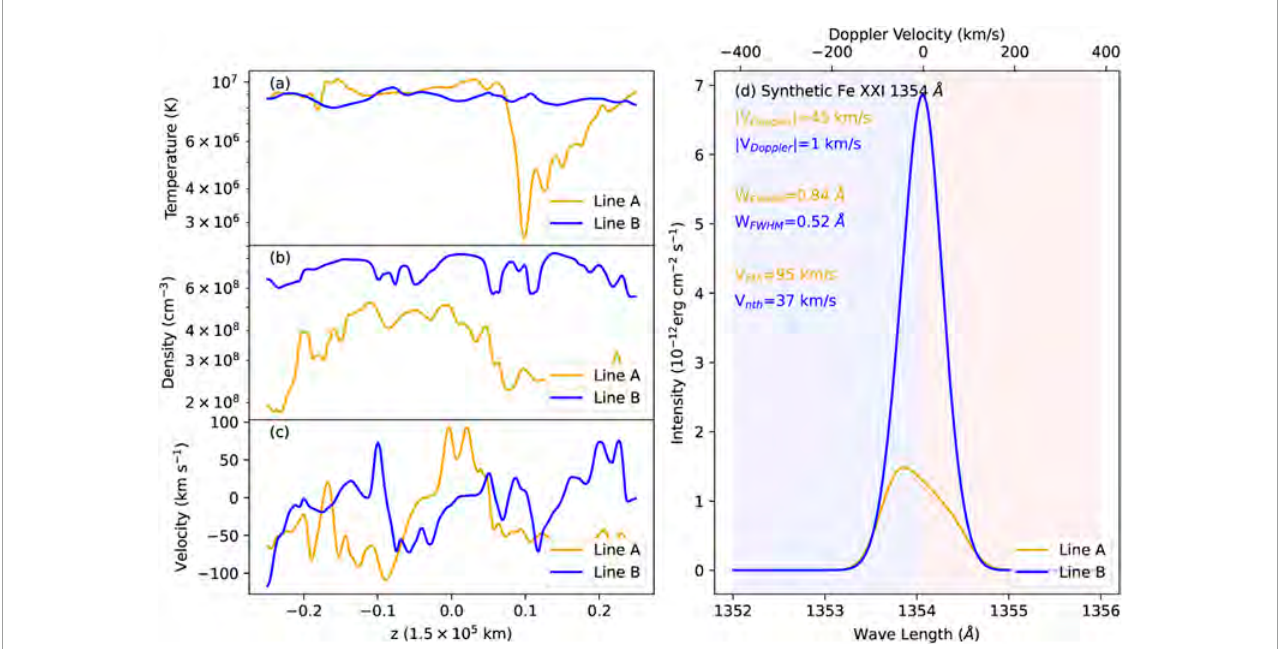
FIGURE 6 Synthetic Fe XXI 1354.08 Å emission along the sampling lines A and B shown in Figure 5 . (A–C) Temperature, density, and velocity profiles along the two sampling lines. (D) Synthetic spectra for lines A and B v Doppler and v nth indicate the Doppler shift velocity and non-thermal velocity, respectively. W FWHM are the line broadenings of each spectral line obtained by measuring the full width at half maximum (FWHM).